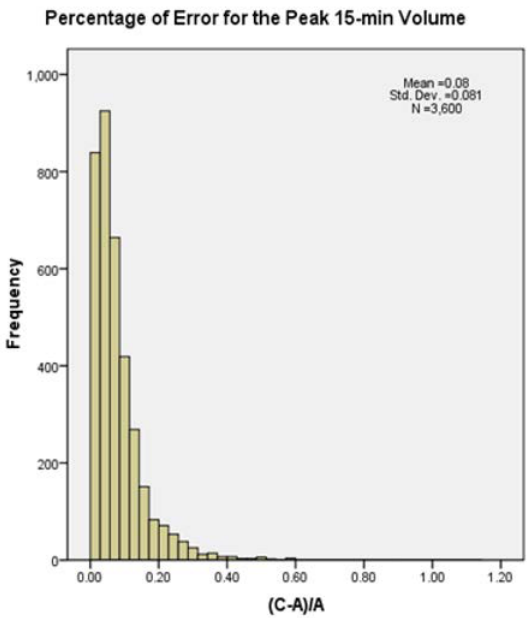
Figure 6. Comparison of Percentage Error between C and A